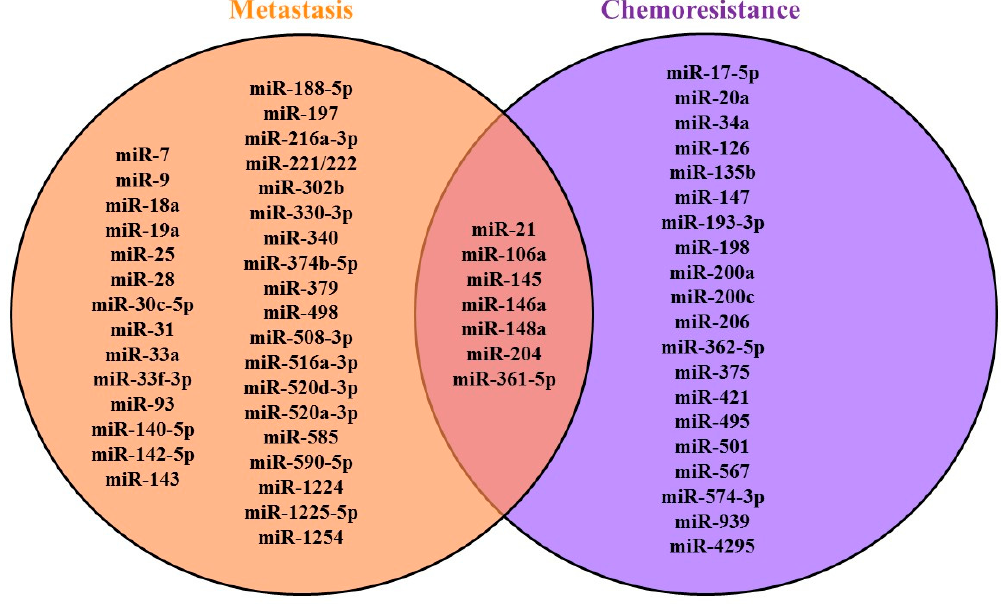
Figure 2. MicroRNAs in GC metastasis and chemoresistance.